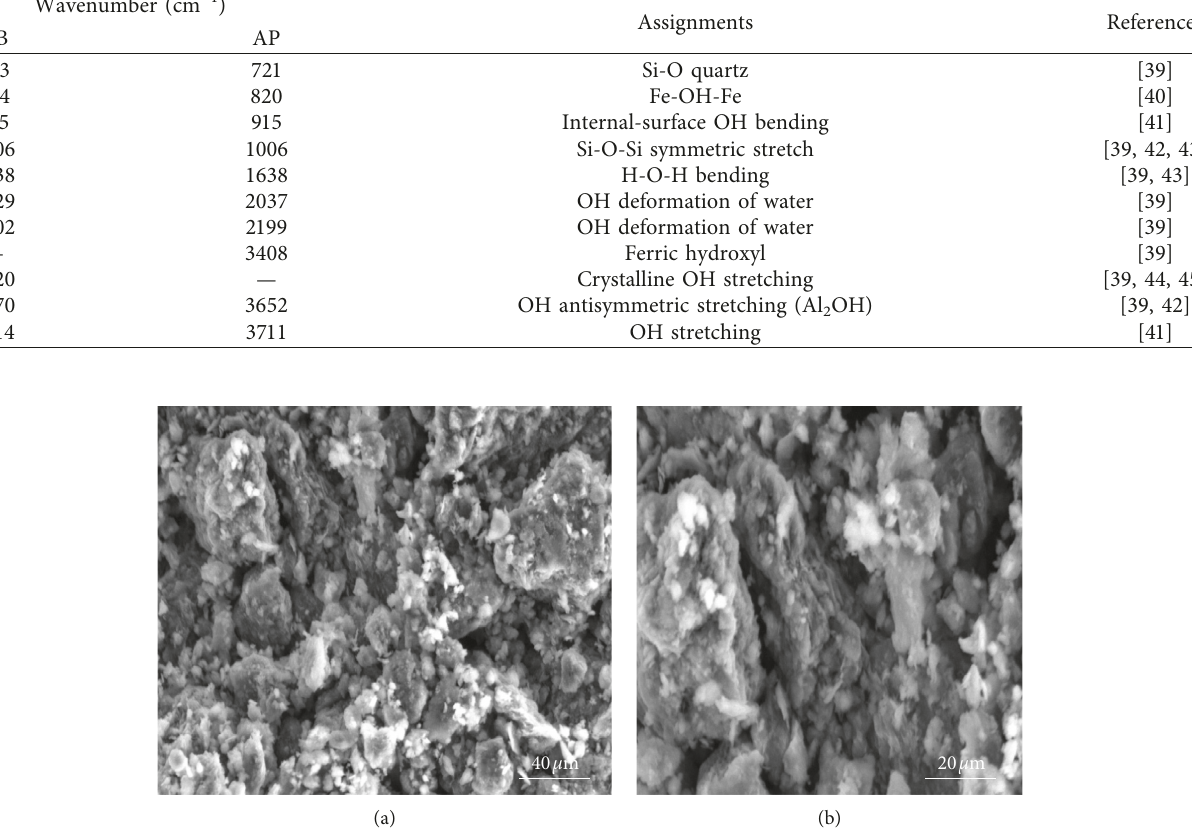
Figure 3: View by scanning electron microscopy of raw clay (AB).